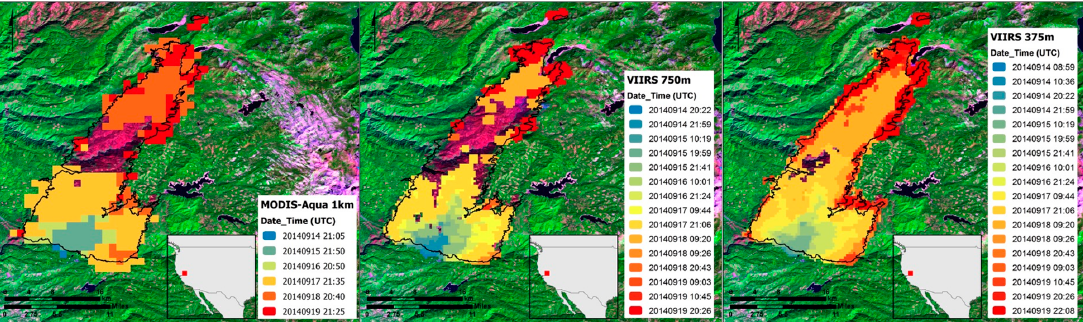
Figure 8. The VIIRS Active Fire Product ( middle panel for 750 m and right panel for 375 m) and comparison with MODIS ( left panel ) King Fire, CA/September 2014. This higher spatial